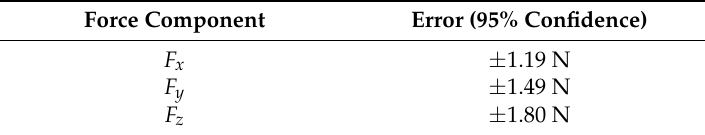
Table 1. Force measurement errors with a confidence level of 95%.